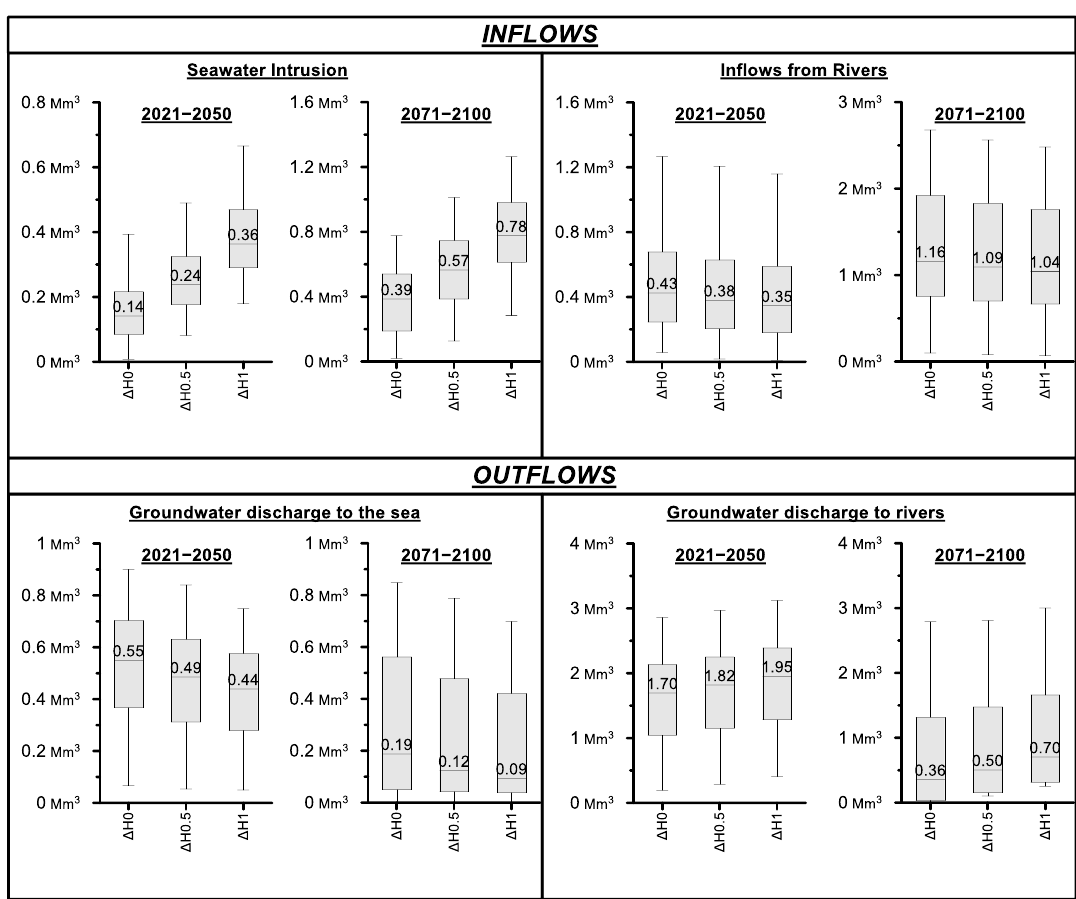
Figure 10. Boxplots presenting the annual simulated variation of inflows and outflows for the two projected periods under no sea level rise (ΔH0), sea level rise of 0.5 m (ΔΗ0.5) and sea level rise of 1 m (ΔΗ1).